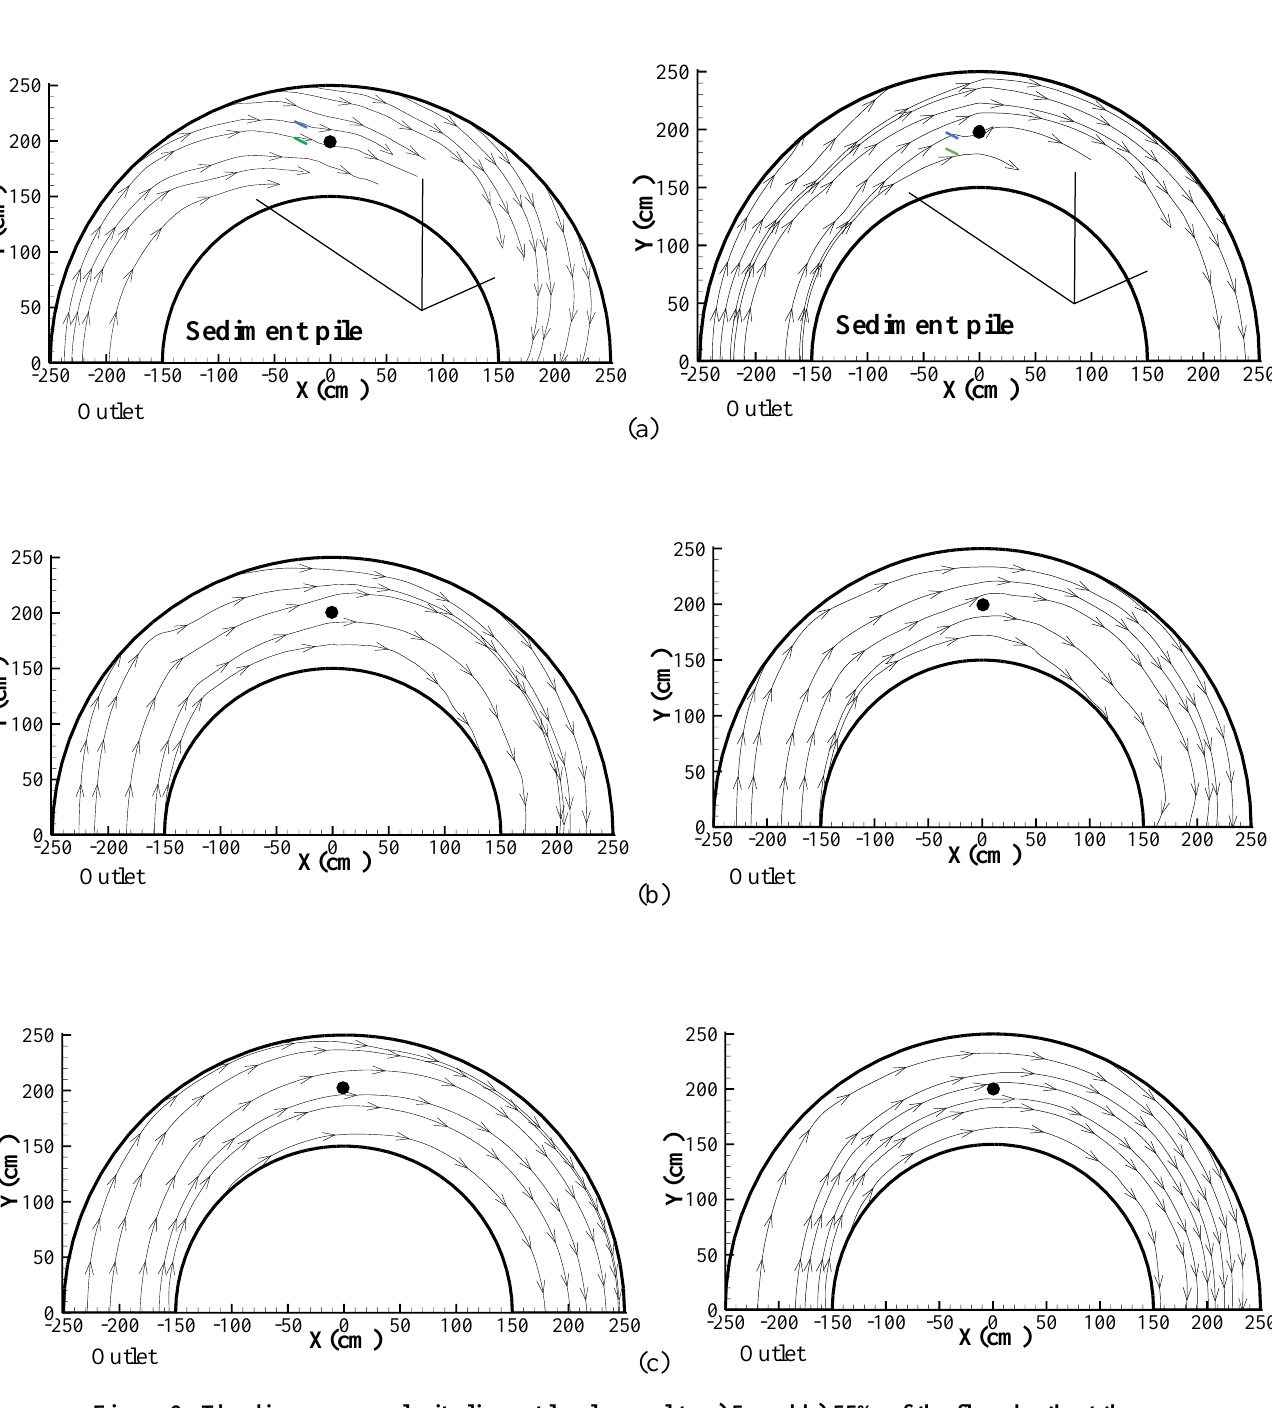
Figure 9. The diagram on velocity lines at levels equal to a) 5, and b) 55% of the flow depth at the beginning of the bend from the bed, and c) 5% of the flow depth at the beginning of the bend from the flow surface. (PFV experiment on the right, and PSV experiment on the